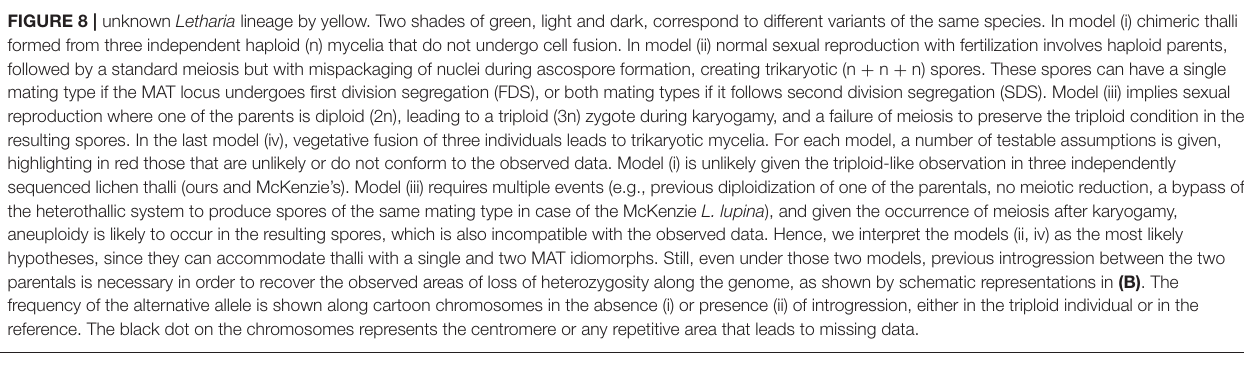
which typically have a high repeat content (Bertazzoni et al.,